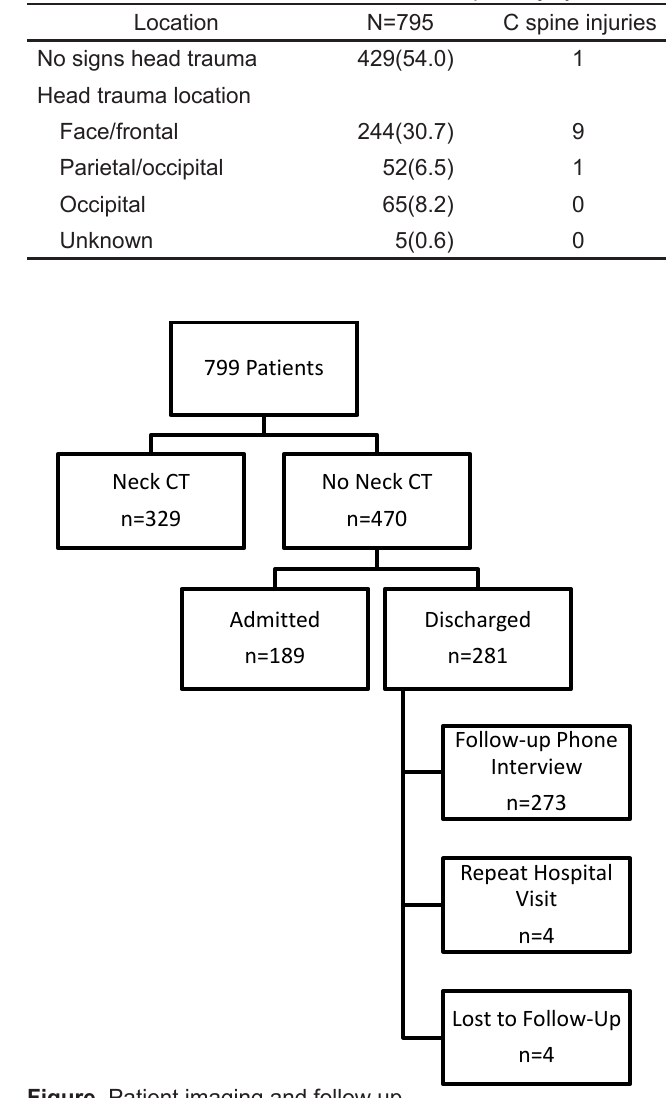
Figure. Patient imaging and follow up. CT , computed